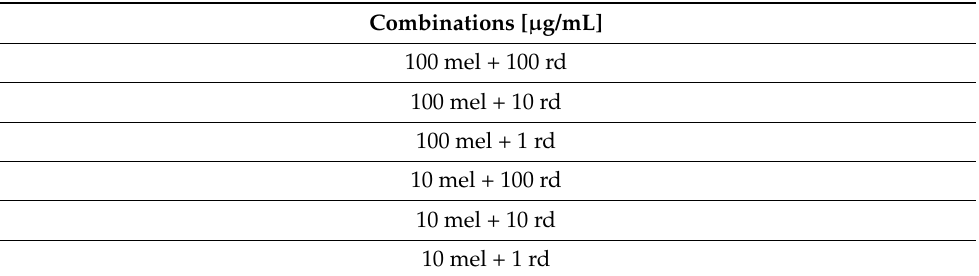
Table 1. Drug combinations used in the experiment: mel-meloxicam + rd-risedronate sodium.